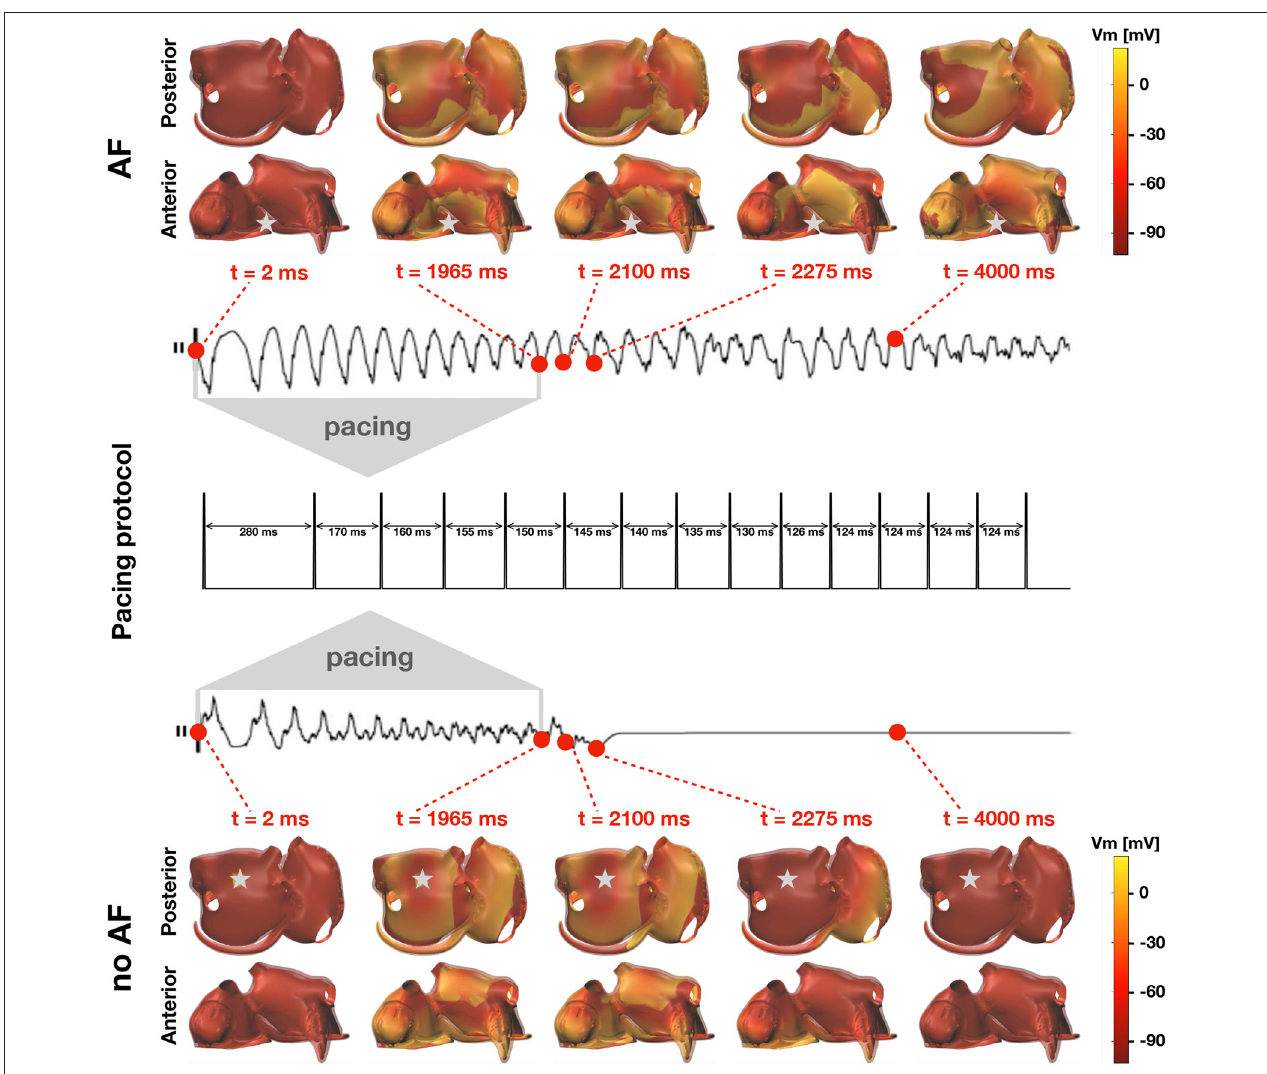
FIGURE 3 | Inducibility of AF in the computer model. Two simulations with different pacing sites (grey stars) and inducibility outputs. The middle plot illustrates the pacing protocol. Top: transmembrane potential resulting from a successful induction of AF and corresponding lead II ECG recording. The stimulation results in a self-sustained activity. Bottom: transmembrane potential resulting from an unsuccessful induction of AF and corresponding lead II ECG recording. The stimulation results in a vanishing